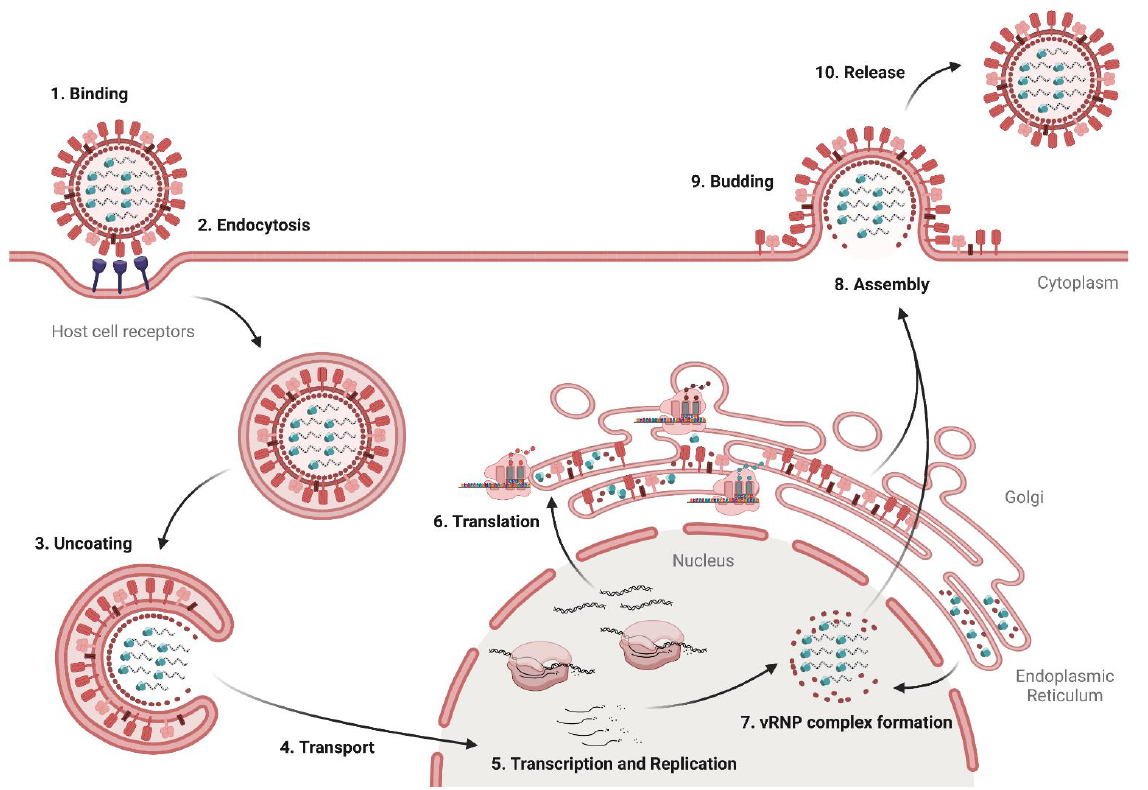
Figure 2. Replication cycle of influenza virus. First, the virus binds via HA to sialic acid residues on the host cell (Step 1) and is taken up into the cell via endocytosis (Step 2). After acidification of the endosome and viral interior, the vRNPs are released in the cytosol (Step 3) and transported in the nucleus (Step 4), where the viral RNA is transcribed and replicated (Step 5). Viral mRNAs are transported in the cytosol for translation (Step 6). NPs and the subunits of the viral polymerase PA, PB1, and PB2 are transported back in the nucleus to form new vRNP complexes (Step 7). vRNPs and HA, NA, and M1 are transported to the cell surface for assembly (Step 8). The virion buds from the cell surface (Step 9). In the final step, NA cleaves sialic acids from the cell surface and progeny virions, enabling virus release from infected cells (Step 10). Adapted from “HIV Replication Cycle”, by BioRender.com (2022) (accessed on 20 September 2022). Retrieved from https://app.biorender. com/biorender-templates (accessed on 20 September